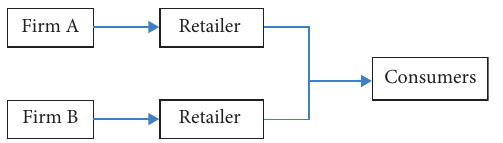
Figure 1: Structure of the supply